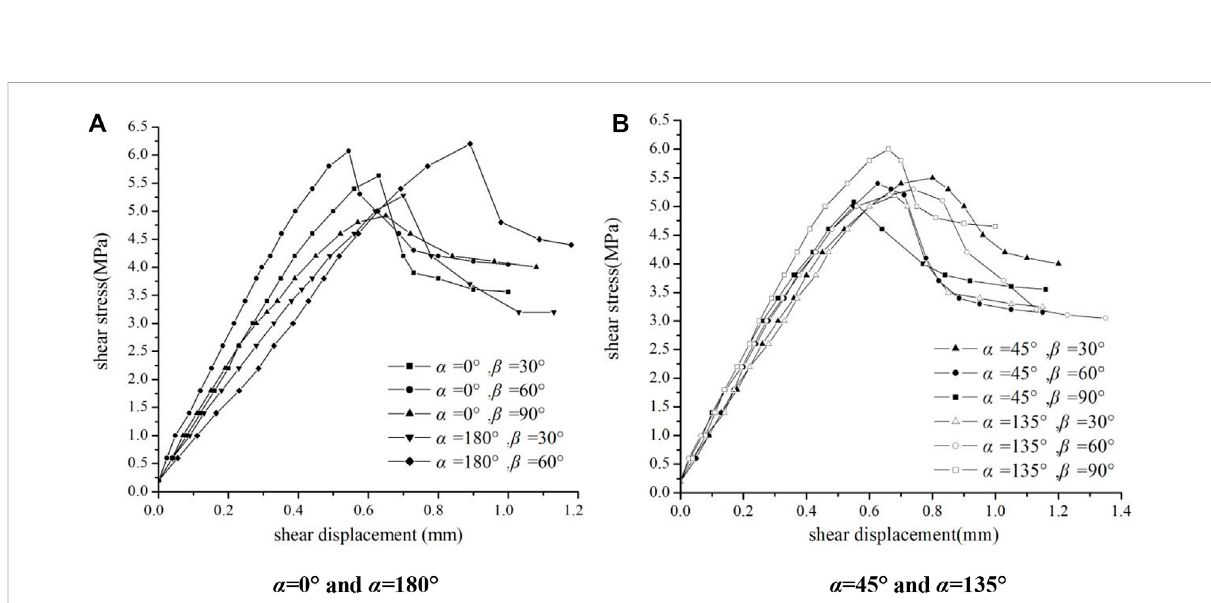
FIGURE 9 Shear stress-shear displacement curve (normal stress is 1 MPa). (A) α = 0 ° and α = 180 ° , (B) α = 45 ° and α = 135 °